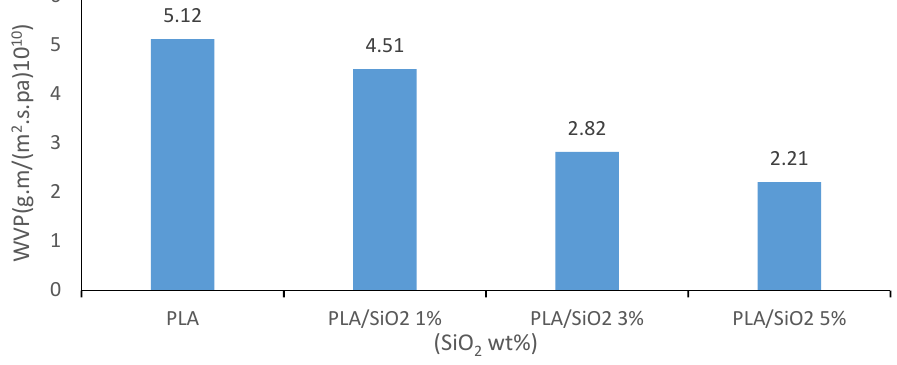
Fig1. The mean of water vapor permeability in in poly lactic acid silicon dioxide nanocomposite